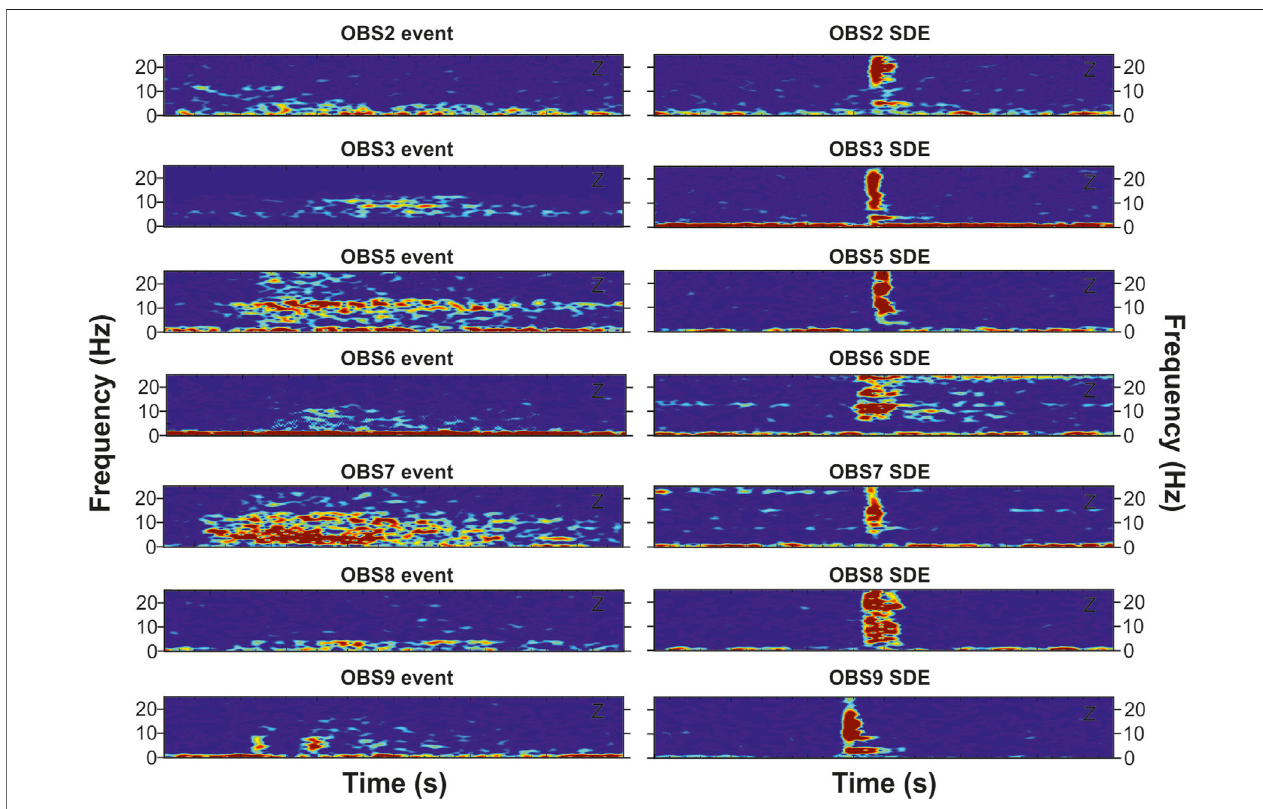
FIGURE11| Spectrogramscomputed onverticalcomponentofearthquakes (left) andSDEs (right) recordedatthesingleOBS.Recordswere fi lteredwithband- passButterworth fi lterinthefrequencyrange2 – 25 Hz.Coloursofspectrogramsareinlog(counts 2 /Hz)unitsandrepresent distributionofenergyoftherecordedsignals asafunctionoftime( x axis)andfrequency( y axis).Warmcolours(red,yellowandgreen)de fi nethedominantspectralamplitudes;coolercolours(lighttodarkblue)de fi ne lower spectral amplitudes and background.